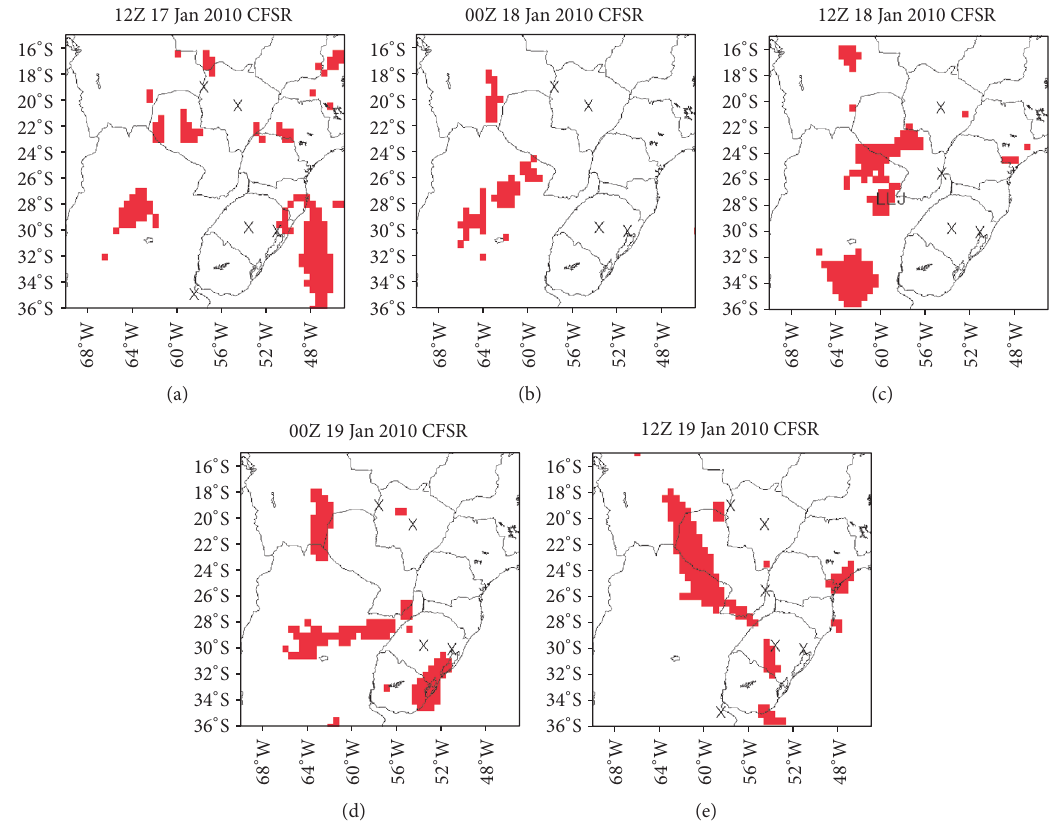
Figure 18: As in Figure 15 but from (a) 12Z 17 January 2010 to (e) 12Z 19 January 2010.